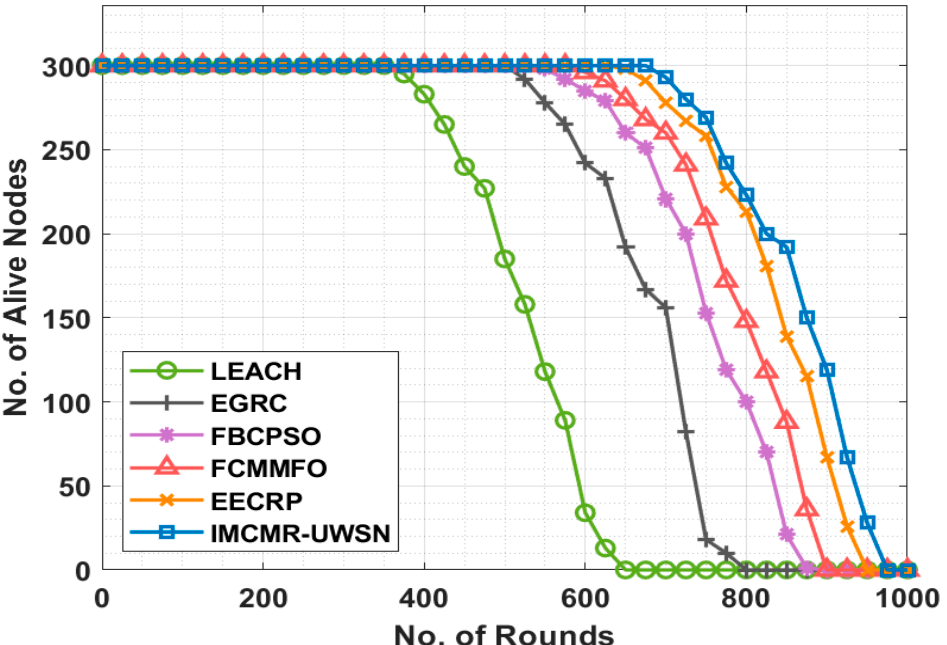
Figure 3. NAN analysis of the IMCMR-UWSN technique.